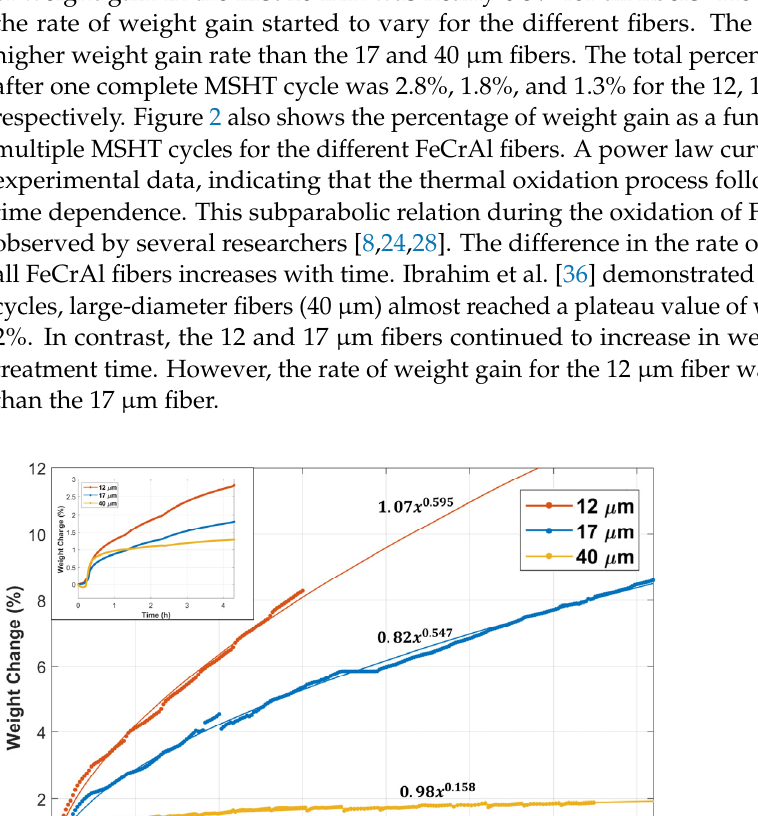
Figure 2. Percentage weight change of the 12, 17, and 40 µm FeCrAl fibers versus time during mul- tiple MSHT cycles. Inset: Percentage weight change of the fibers during the first MSHT cycle.